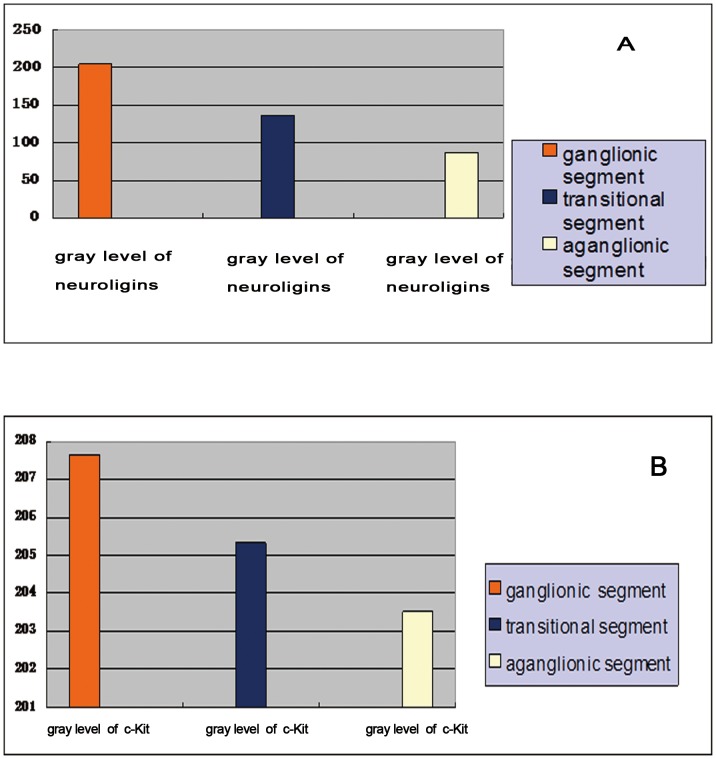
The gray level of neuroligins expressed in Western blot analysis was 204.07±8.81 in ICC-MY of ganglionic colonic segments, 136.13±13.2 in transitional segments and 86.65±4.54 in aganglionic colonic segments, and the difference of gray level had statistical significance (204.07±8.81 vs 136.13±13.2, P<0.05; 136.13±13.2 vs 86.65, P<0.05; 204.07±8.81 vs 86.65±4.54, P<0.05).
(
Figure 7A
). The gray level of c-Kit expressed in Western blot analysis was 207.66±13.5 in ICC-MY of ganglionic colonic segments, 205.32±10.75 in transitional segments and 203.52±11.99 in aganglionic colonic segments and there was no statistical difference among aganglionic, transitional and ganglionic colonic segments (207.66±13.5 vs 205.32±10.75, P>0.05; 205.2±10.75 vs 203.52±11.99, P>0.05; 207.66±13.5 vs 203.52±11.99, P>0.05 ). (Figure 7B).